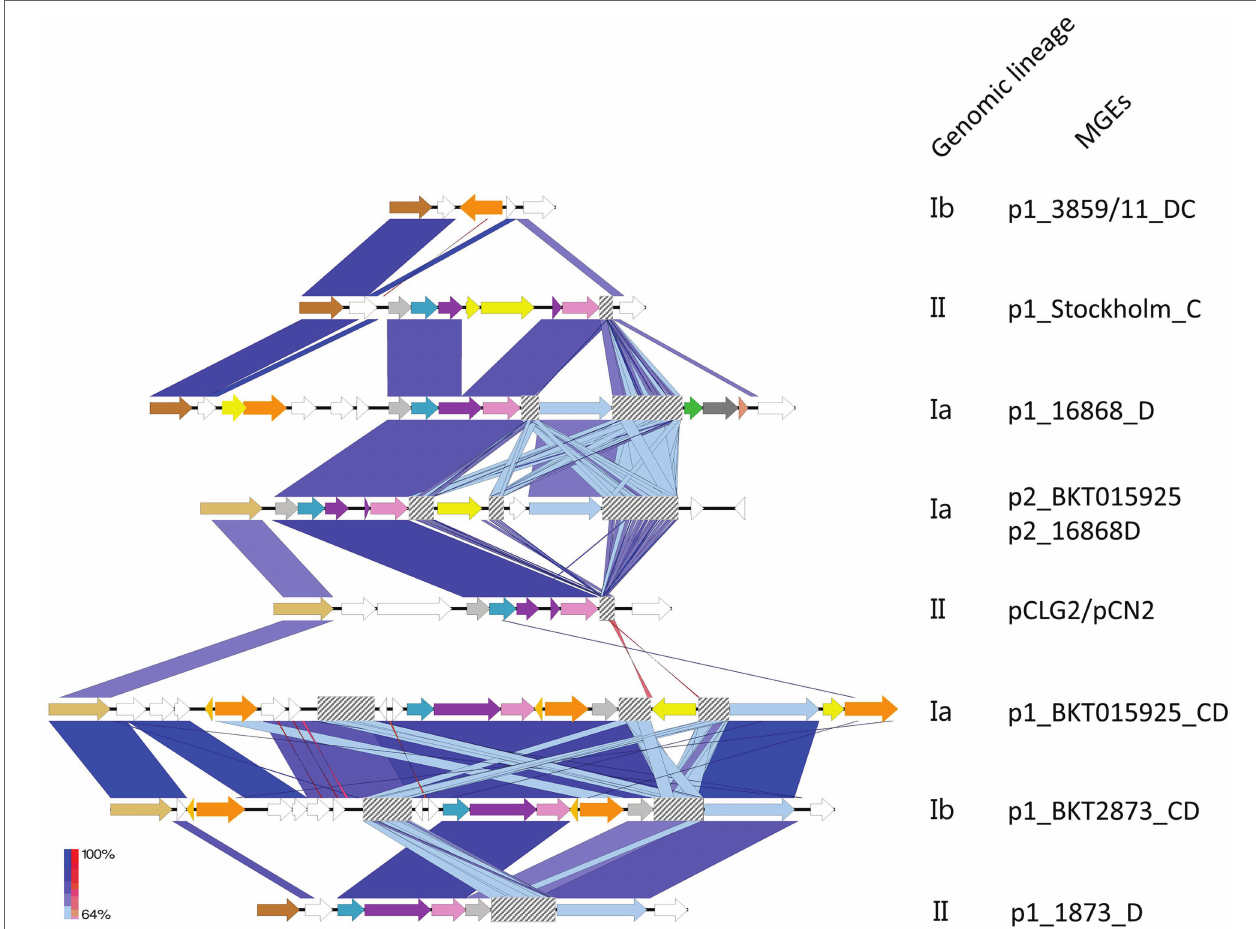
FIGURE 2 | Comparison of the architecture of the CRISPR loci located in MGEs. Annotated CDS are shown in white. CRISPR loci were always found in close proximity to a replication initiation protein (first CDS on the left, dark and light brown). TnpB Cas14a related transposases are shown in orange; hypothetical transposase regulators, light orange; the IS256-like element ISCbo4 family transposase integrated into the CRISPR arrays of p1_BKT015925 and p2_BKT015925, yellow. CRISPR-Cas type Ib, arrows color coded as in Figure 1 (light gray = Cas5, Blue indigo = Cas6, Purple = Cas8b, Pink = Cas7, Light blue = Cas3, Green = Cas4, Dark grey = Cas1, and Orange = Cas2). CRISPR arrays are shown as gray-checkered boxes. BLAST hits are colored on a gradient ranging from minimum (light blue) to maximum BLAST scores (dark blue). Reverse matches are shown in a red gradient. Created with Easyfig (Sullivan et al.,